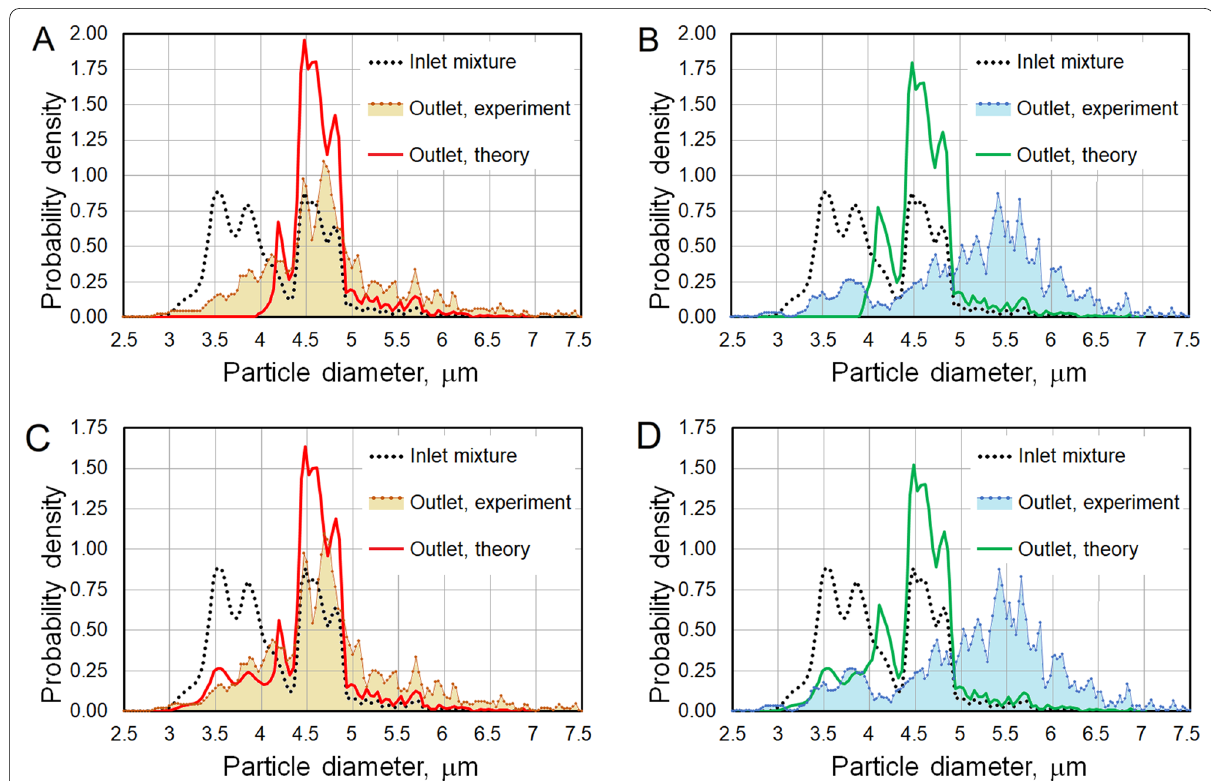
Fig. 5 Separation of particle mixture in deep ( A and C ) and shallow ( B and D ) channels. Idealized separation model in a deep A and shallow B channel, when separation efficiency is only affected by a change in the critical diameter. Realistic separation model in a deep C and shallow D channel, when 30% of the particles do not separate into large and small, reach the outlet and create noise in the particle size